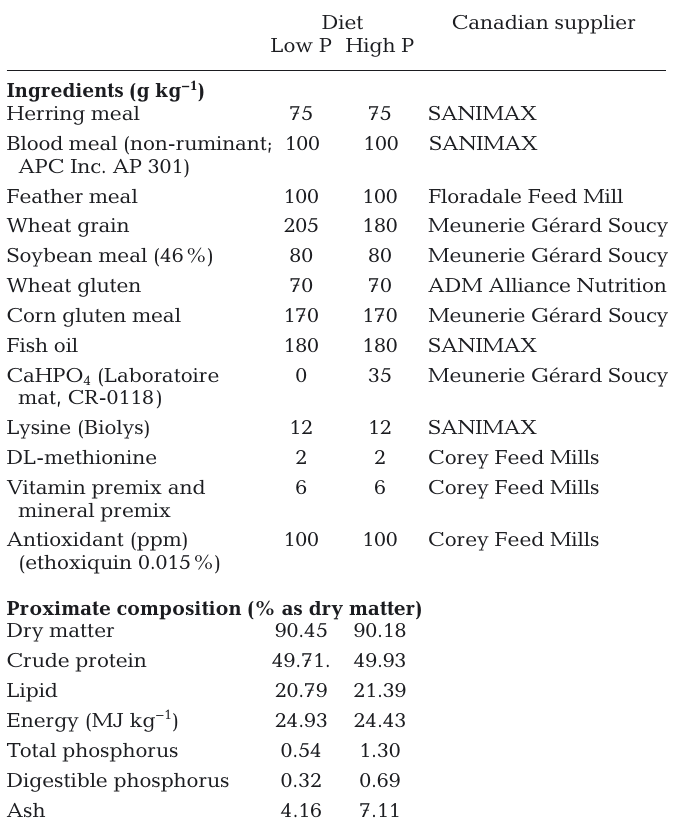
Table 1. Oncorhynchus mykiss . Experimental diet formulation (as fed basis) and chemical composition (dry matter basis). Vitamin premix and mineral premix: supplied the following: as per NRC (1993) (to provide mg kg −1 except as noted): retinyl acetate, 2500 IU; cholecalciferol, 2400 IU; tocopheryl acetate, 50; menadione, 10; thiamin, 1; riboflavin, 4; pyrido - xine, 3; Ca-pantothenate, 20; vitamin B-12, 0.01; niacin, 10; biotin, 0.15; folic acid, 1; choline, 1000; inositol, 300; magnesium carbonate, 1.24 g; calcium carbonate, 2.15 g; potassium chloride, 0.90 g; sodium chloride, 0.40 g; potassium iodide, 0.4; copper sulfate, 30; cobalt sulfate, 0.2; ferric sulfate, 0.20 g; manganese sulfate, 30; zinc sulfate, 40; sodium fluoride, 10. Digestible phosphorus (P) = Total P in the diet × P